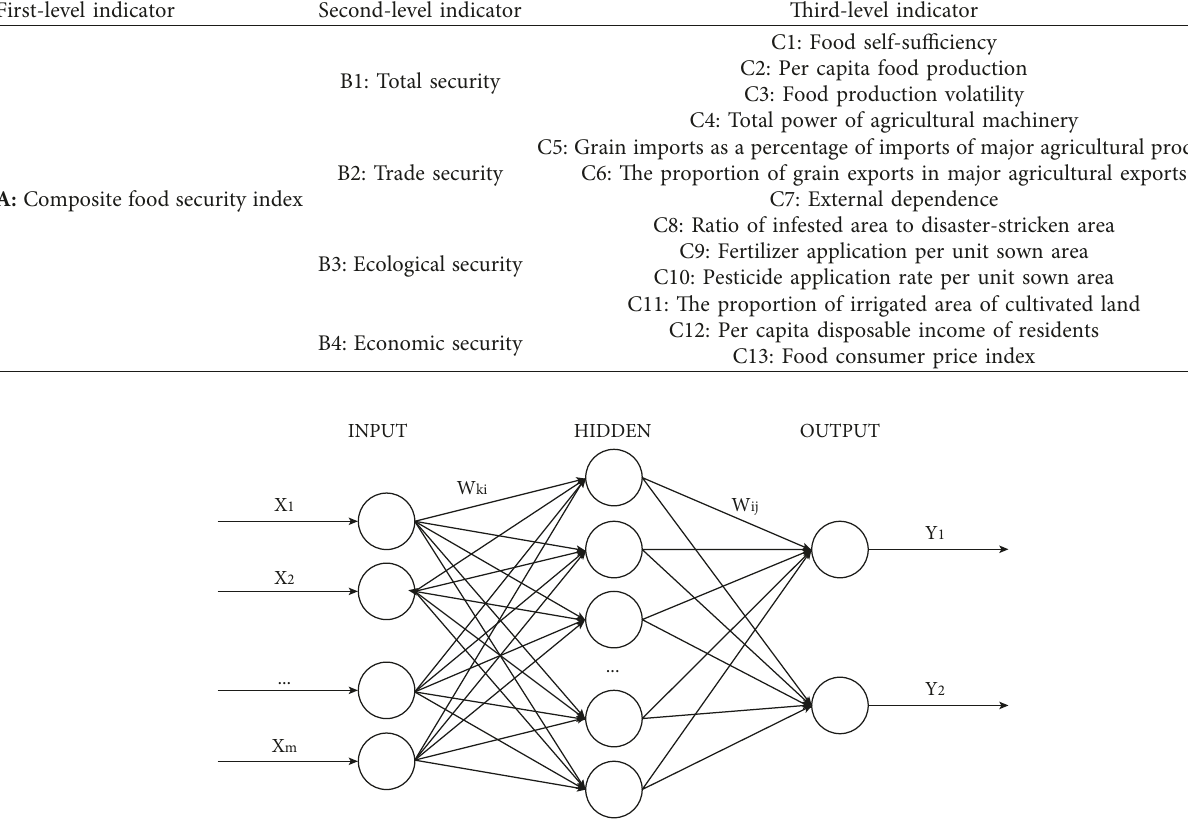
Figure 1: BP neural network structure